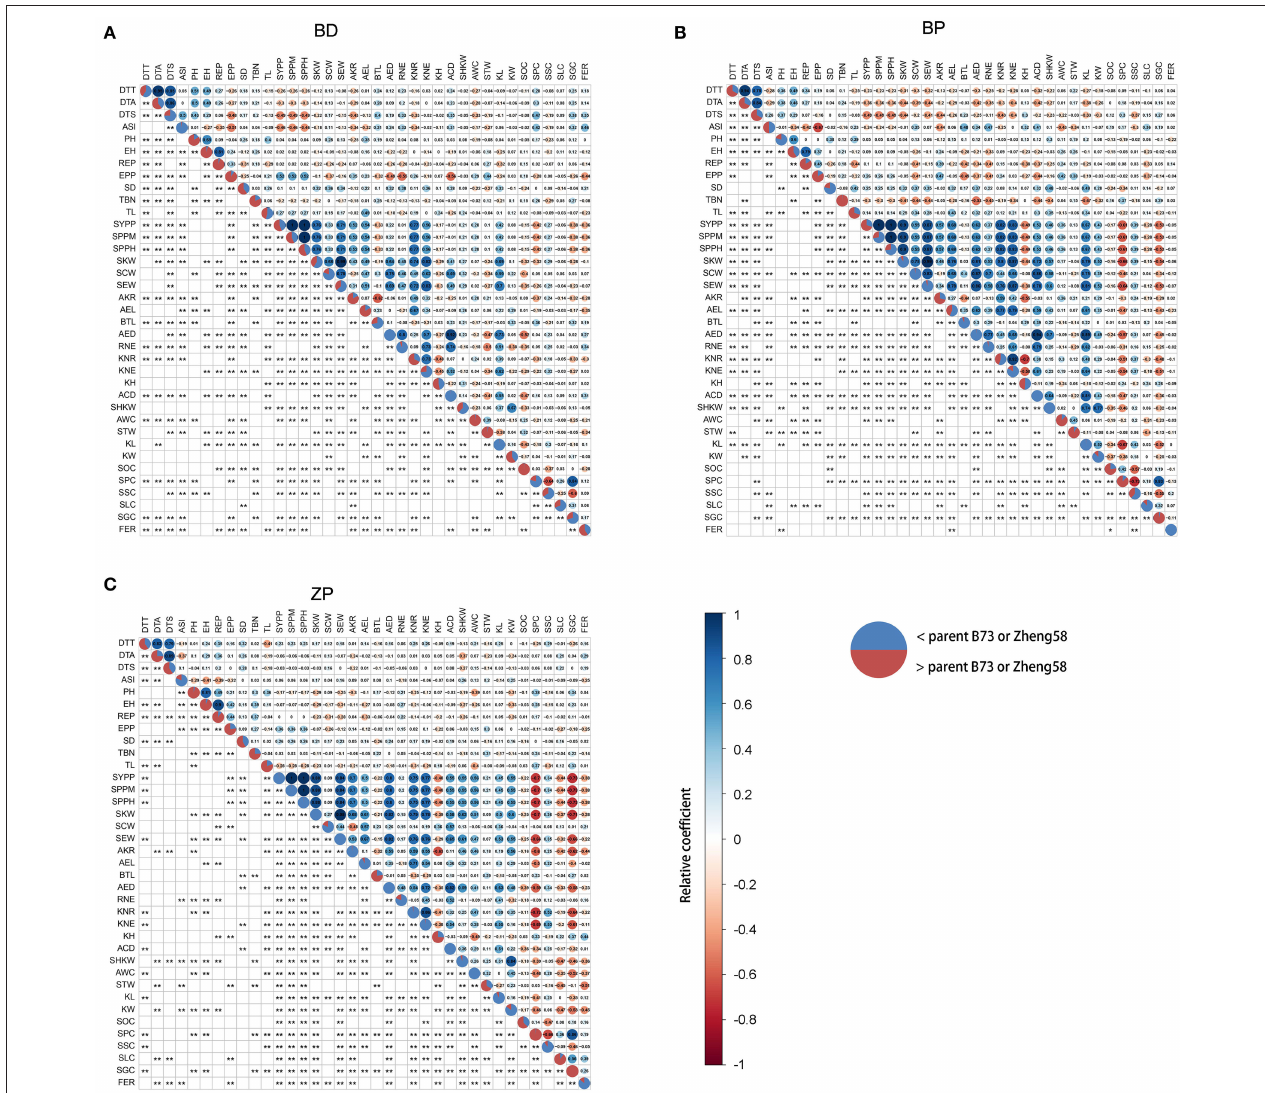
FIGURE 4 | (A–C) Correlation between FER resistance and other agronomic traits. The BLUP value of FER from six replicates in two environments and BLUP values of agronomic traits from 15 replicates in five environments were used here. The relative coefficient was represented by the area and color of filled circle labeled from dark red to dark blue in the right upper part of a panel, and the numerical value of the relative coefficient was displayed in the filled circle. Significance was displayed as an asterisk in the left lower part of a panel. * p < 0.05, ** p < 0.01. Pie charts on the diagonal were used to show the proportion of progeny with corresponding traits higher (red) or lower (blue) than their maize parents. DTT, day to tasseling; DTA, day to anthesis; DTS, day to silking; ASI, anthesis_silking day; PH, plant height; EH, ear height; REP, ratio of ear height and plant height; EPP, ear number per plant; SD, stem diameter; TBN, tassel branch number; TL, tassel length; SYPP, standard yield per plant; SPPM, standard production per Mu; SPPH, standard production per hectare; SKW, standard kernel weight per ear; SCW, standard cob weight per ear; SEW, standard ear weight per ear; AKR, average kernel rate; AEL, average ear length; BTL, barren tip length; AED, average ear diameter; RNE, row number per ear; KNR, kernel number per row; KNE, kernel number per ear; KH, kernel height; ACD, average cob diameter; SHKW, standard hundred kernel weight; AWC, average water content; STW, standard test weight; KL, kernel length; KW, kernel width; SOC, standard oil content; SPC, standard protein content; SSC, standard starch content; SLC, standard lysine content; SGC, standard glutamate content. 8b ( ATG8b) , a polyphenol oxidase, and an unknown gene, Collectively, qFER bd10.140, qFER zp4.066, and qFER zp5.116 were induced by XY-1 ( Figure 6 ; Supplementary Table S6 ), were the most reliable QTLs for FER resistance in the BP and and one gene, namely, Starch Synthase 3 ( SS3) , was directly ZP populations. qFER bd10.140 and qFER zp4.066 were highly associated with plant yield. The regions of qFER zp4.066 and reliable, resistance-yield synergistic QTLs. Based on the reference qFER zp5.116 were large and contained a large number of genes genome, there are 14 genes in qFER bd10.140, among which ( Supplementary Table S6 four genes, namely, Polyamine Oxidase 3 ( PAO3) , Autophagy